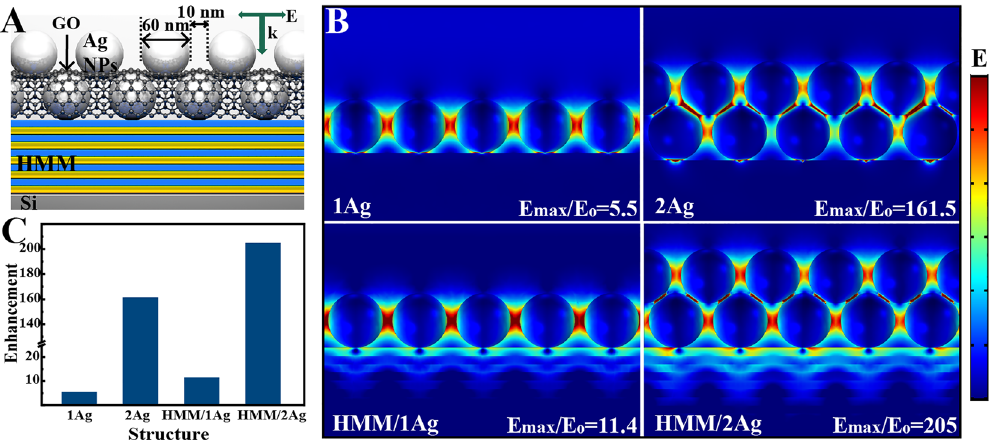
Figure 1: (A) Simulated composite nanostructure. Incident wavelength: 532 nm. (B) Electric fi eld distribution of various structures. (C) Comparison of the simulated electric fi eld enhancement of various